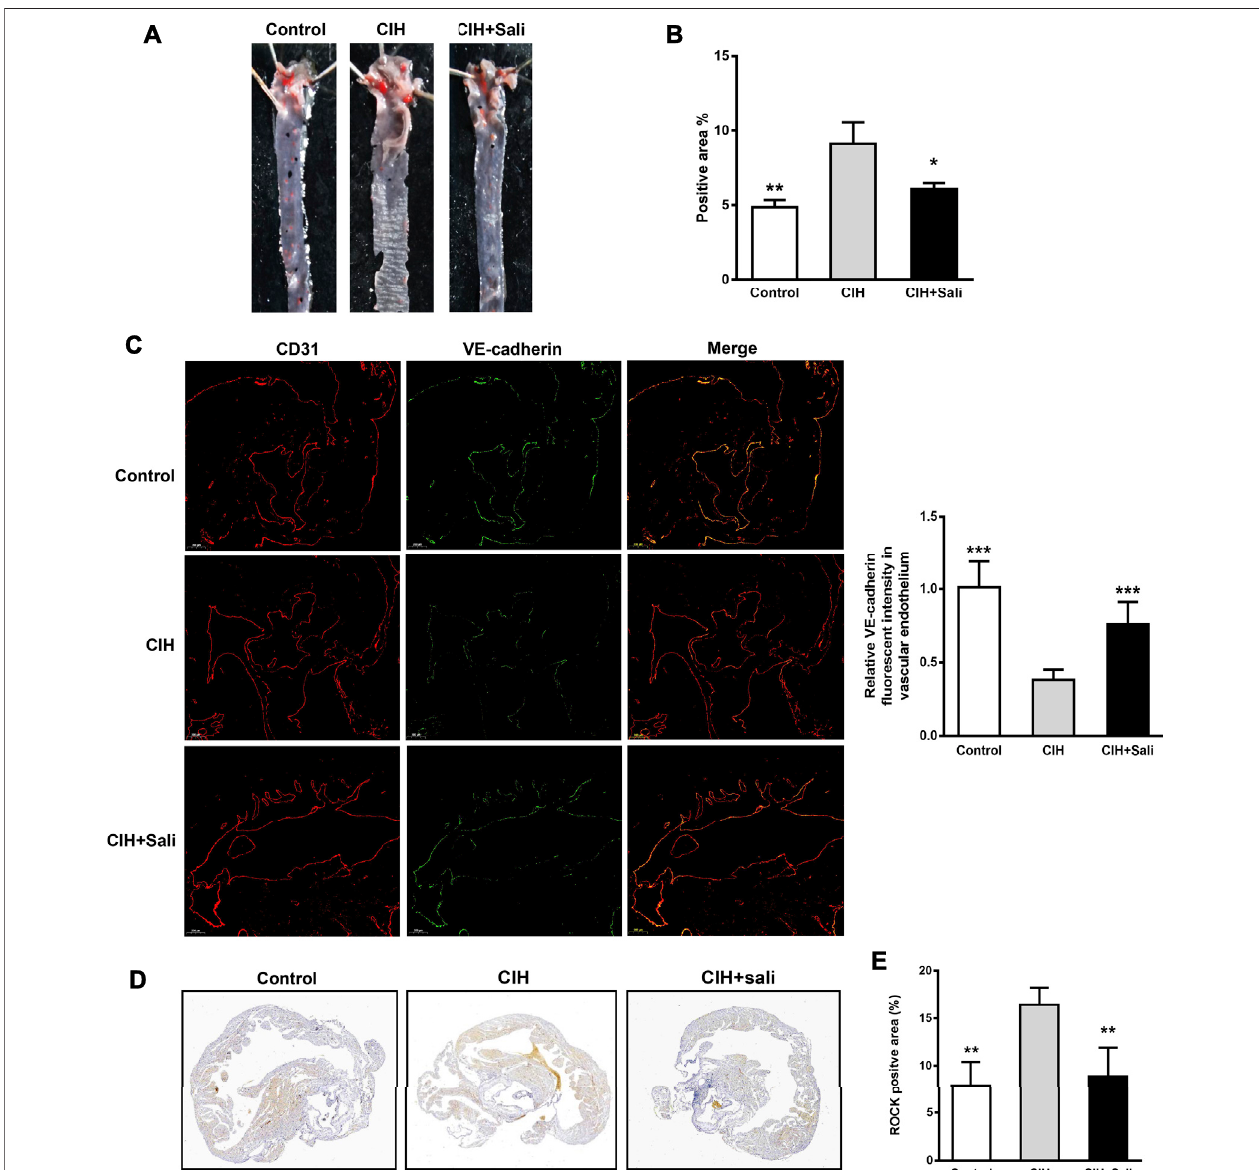
FIGURE1| SalidrosideattenuatedCIH-aggravatedatherosclerosisinApoE -/- mice.MaleApoE -/- micewererandomlydividedintonormoxia(control),CIH,andCIH + Sali groups. After experimental intervention for 7 weeks, mice were sacri fi ced under anesthesia (A) Representative images of aortic Oil Red O staining (B) Quantitative summary of atherosclerotic lesions in aortas ( n (cid:1) 4) (C) Immuno fl uorescence staining of VE-cadherin and CD31 and relative fl uorescent intensity of VE-cadherin in the endotheliumofaortic roots(5 × magni fi cation, n (cid:1) 3sectionsper tissue,atleastthreeanalysissites perslide) (D) PlaquesofaorticrootswerestainedwithROCK(2 × magni fi cation) (E) Quantitative summary of ROCK expression in aortic root plaques ( n (cid:1) 4). CIH, chronic intermittent hypoxia; Sali, salidroside; VE-cadherin, vascular endothelial cadherin; ROCK, Rho-associated protein kinase. All data are presented as mean ± SD. * p < 0.05, ** p < 0.01, and *** p < 0.001 compared with CIH group.